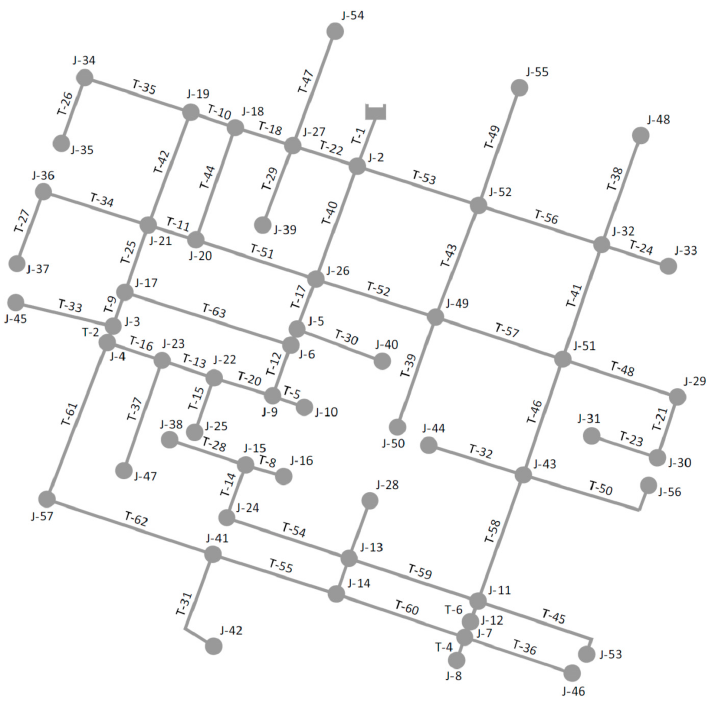
Figure 5. Network model with intermittent water supply to sectorize.